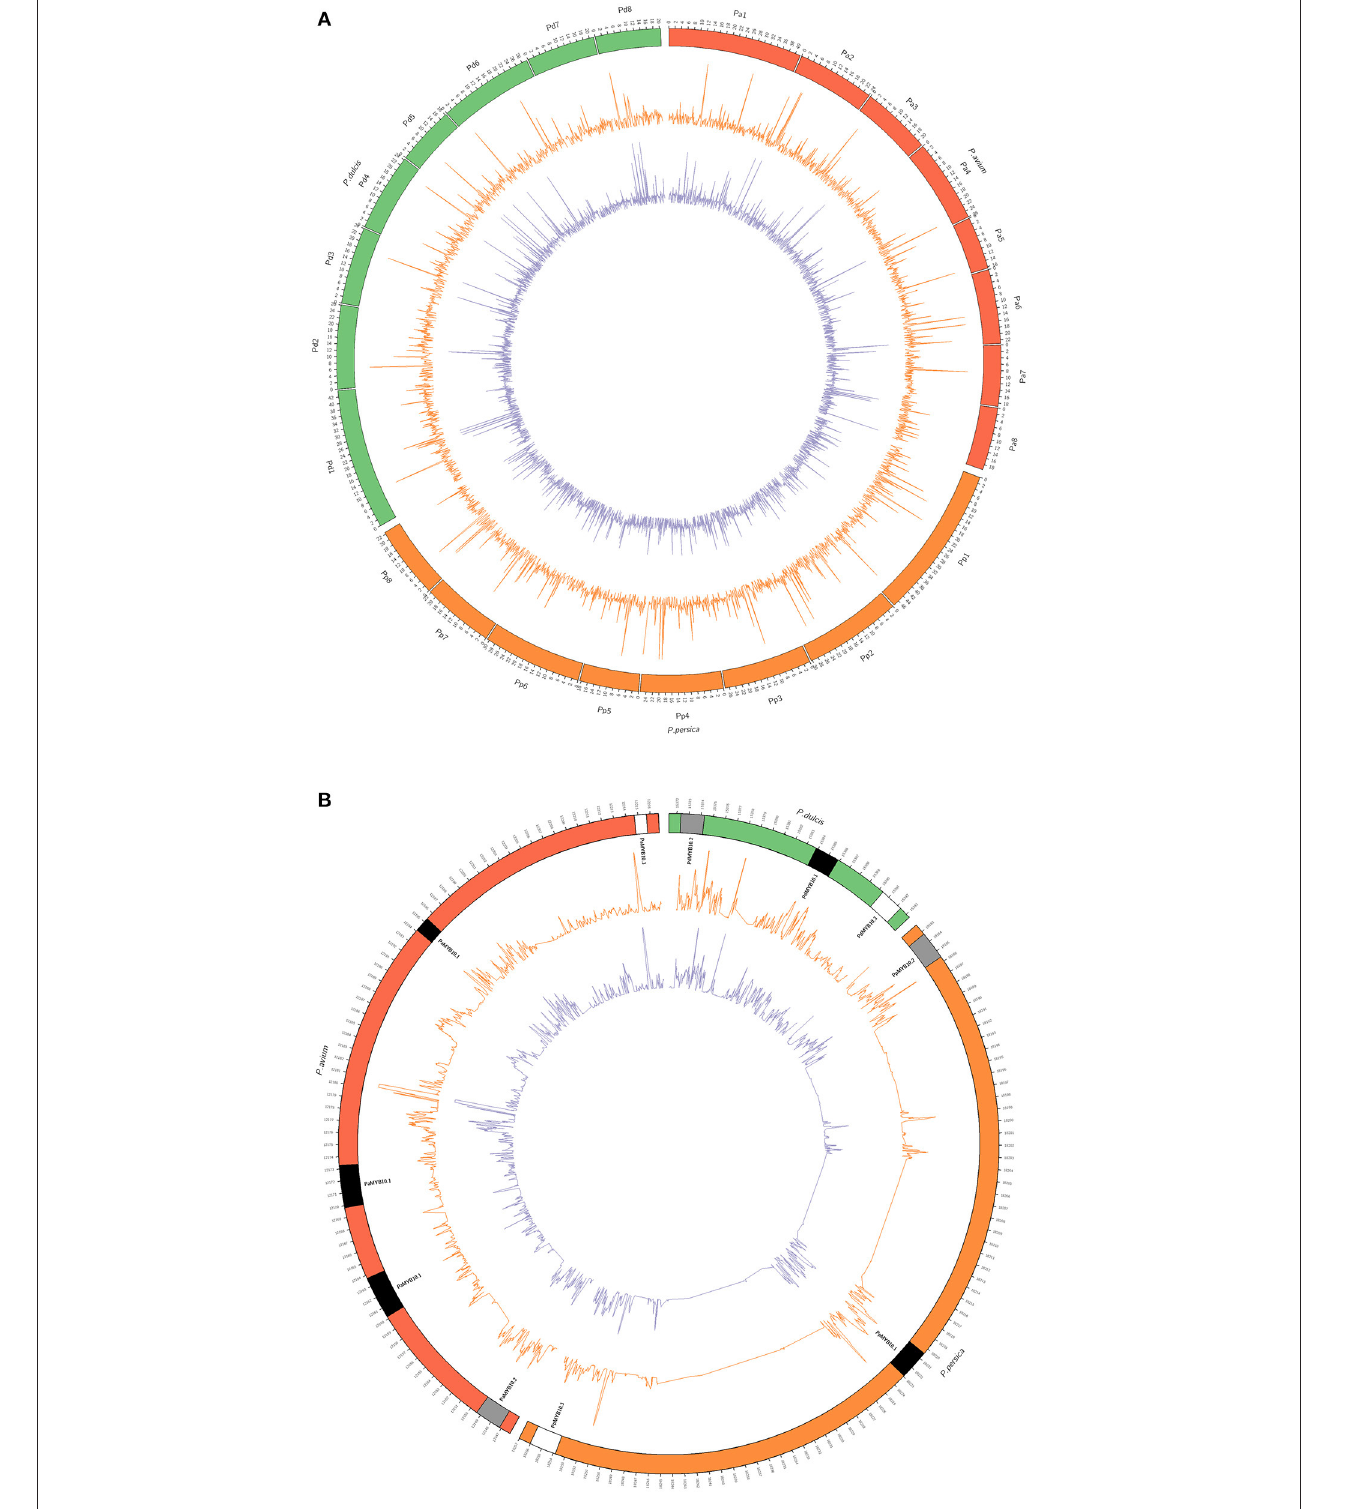
FIGURE 4 | Circular plots of the sequencing depth of C20 (orange line) and C46 (purple line) alignments against the genomic reference sequences of Prunus avium (Shirasawa et al., 2017), Prunus persica (Verde et al., 2017), and Prunus dulcis (Alioto et al., 2020). (A) Whole-genome alignment (genomic units in megabases) and (B) alignment of the chromosome 3 MYB10 region (genomic units in kilobases). MYB10 genes ( MYB10.1 in black, MYB10.2 in gray, and MYB10.3 in white) are represented in their corresponding genomic position for each reference species. Depth was normalized for a better visualization and sequence